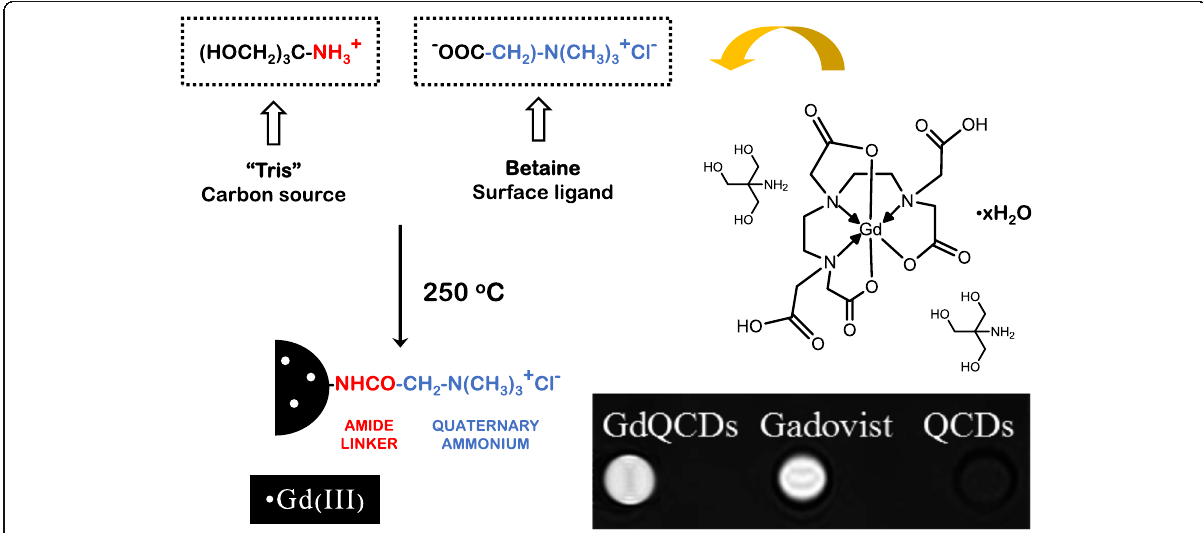
Fig. 11 Synthesis of Gd-QCDs. The Gd(III) centers are immobilized in the carbonaceous matrix through coordination by residual O and N heteroatoms [97]. The inset shows the MRI positive contrast effects in T1-weighted images of the Gd-QCDs and the commercial Gd-based contrast